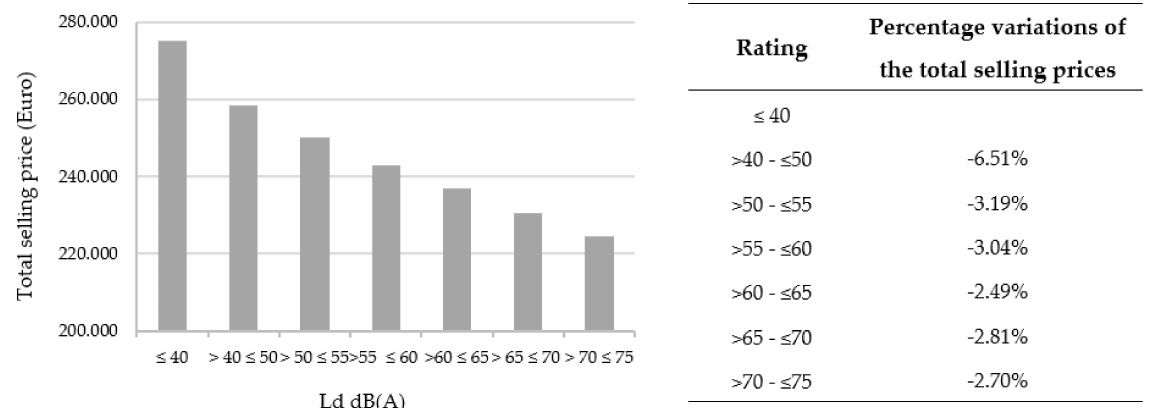
Figure 7. Functional relationship between the Ld label and the prices and percentage variations for the noise pollution class rating for the OMI central area of the city of Bari.